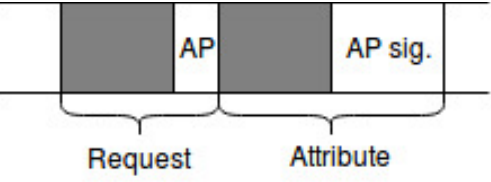
Figure 1. Bit commitment with request and later attached attribute